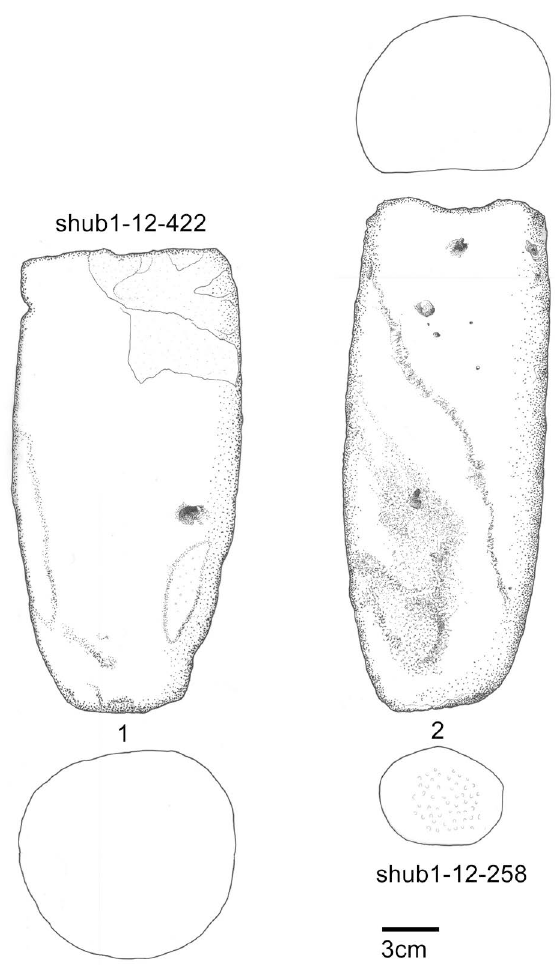
Figure 12: Fragments of very large pestle-handstone dubbed “heavy-duty